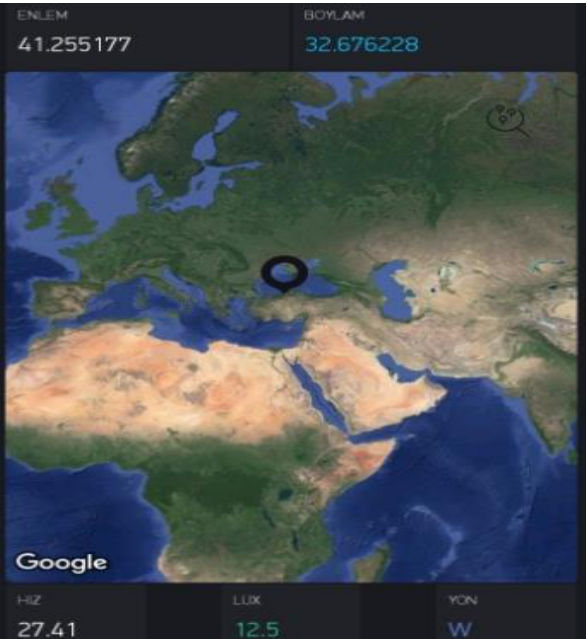
Figure 3.4. Brightness Level Control Card Proteus Circuit Drawing